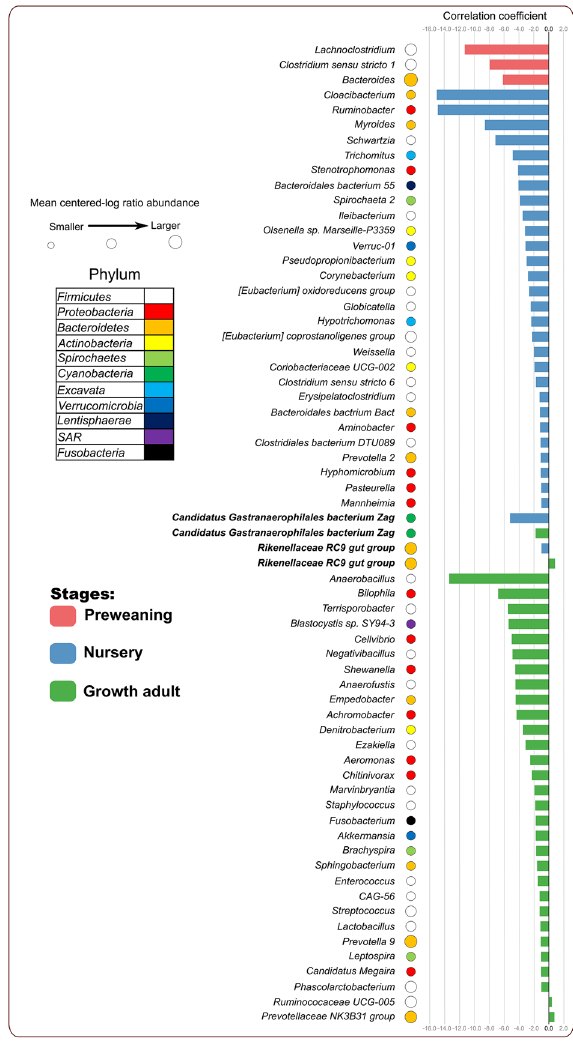
Figure 5. SPIEC-EASI correlation results between Kazachstania slooffiae and genera 18,38–40 . Figure was edited in Inkscape version 1.0.2 (https:// inksc ape. org/) 88